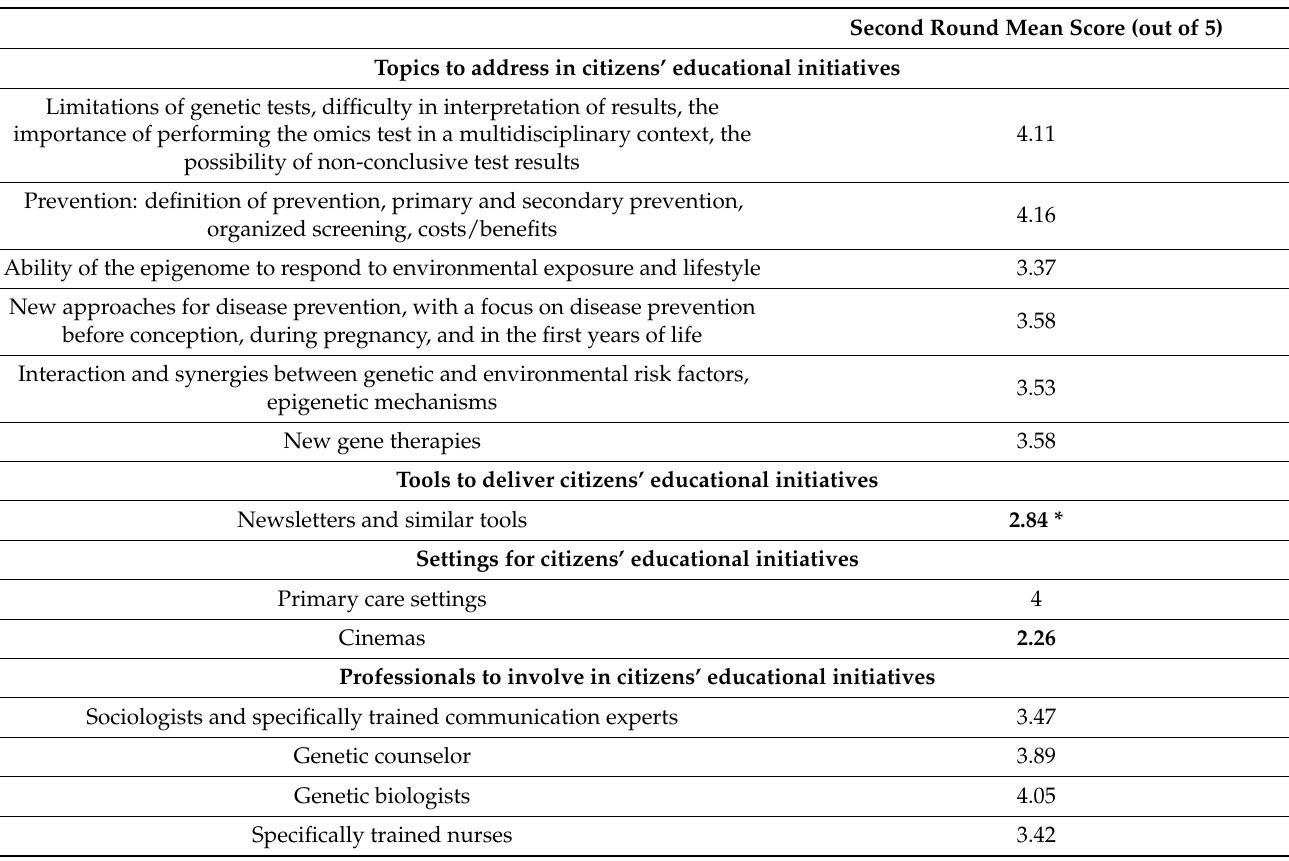
Table 2. New items proposed in the first round and results of the second round of the Delphi